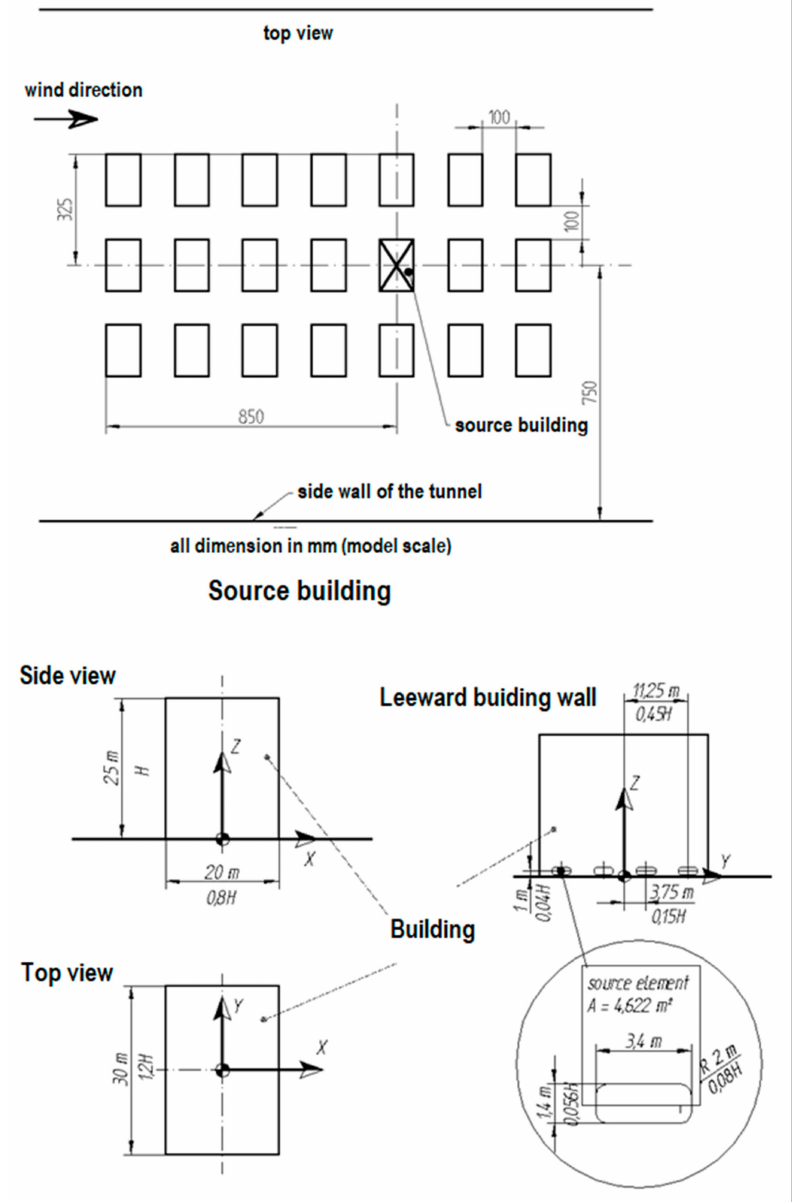
Figure 1. Dimensions of the building models, the source building, and the source